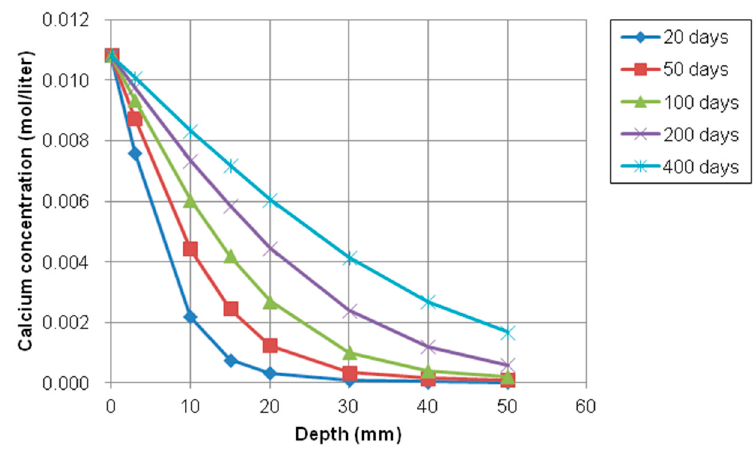
Figure 12. Profile of sodium concentration at different depth over time.